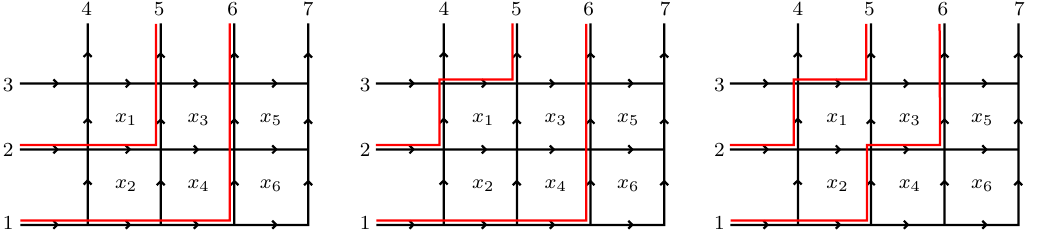
Figure 15 . Collections of non-intersecting paths in Path (3 ; 5 ; 6) of Web 3 ; 7